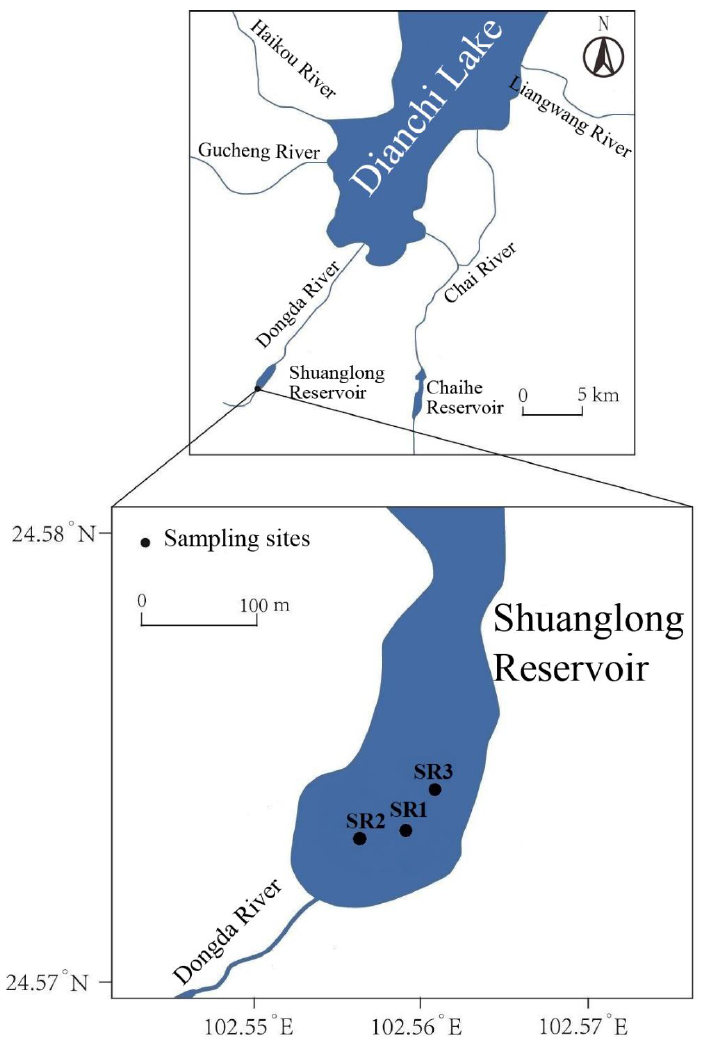
Figure 1. Distribution of sample points in the Shuanglong reservoir.